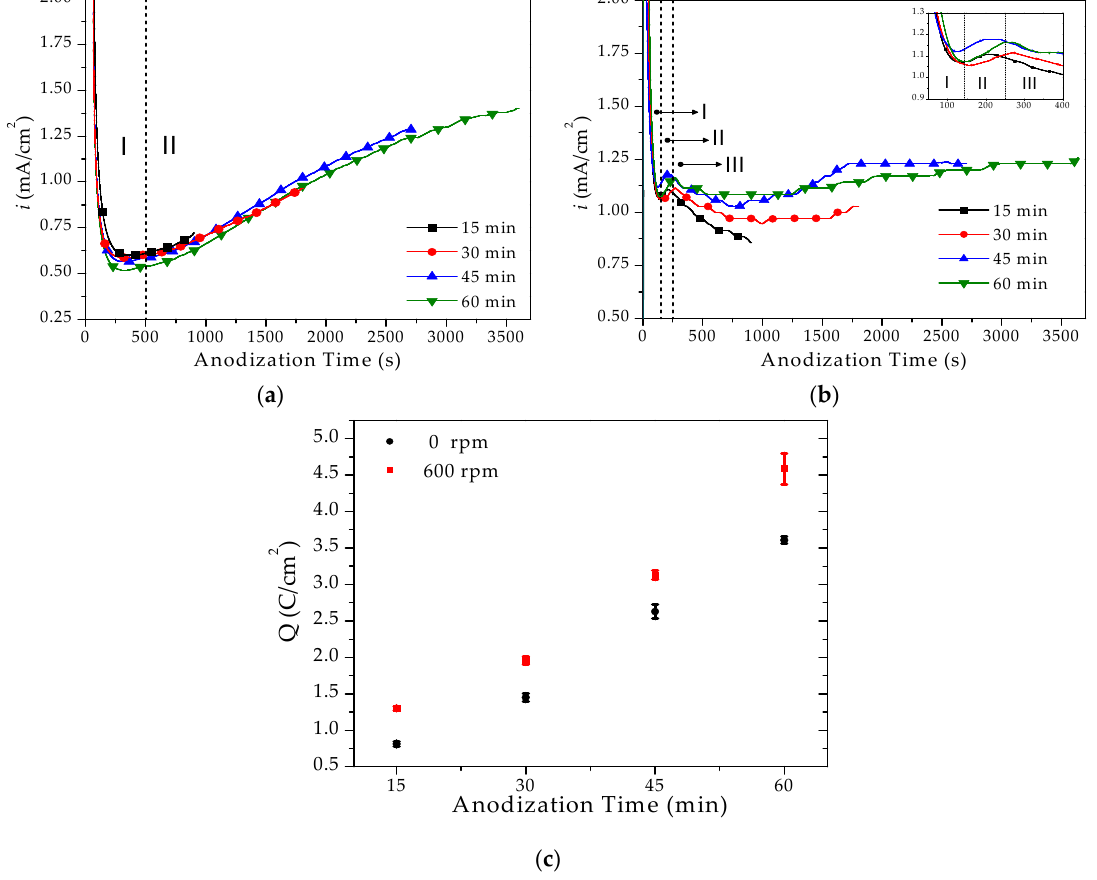
Figure 3. Current density–time responses for anodizing on 304L SS in ethylene glycol-NH 4 F-H 2 O electrolyte for different anodizing time at ( a ) 0 rpm; ( b ) 600 rpm stirring speeds. ( c ) Charge density obteined of current density-time plots at 0 and 600 rpm.